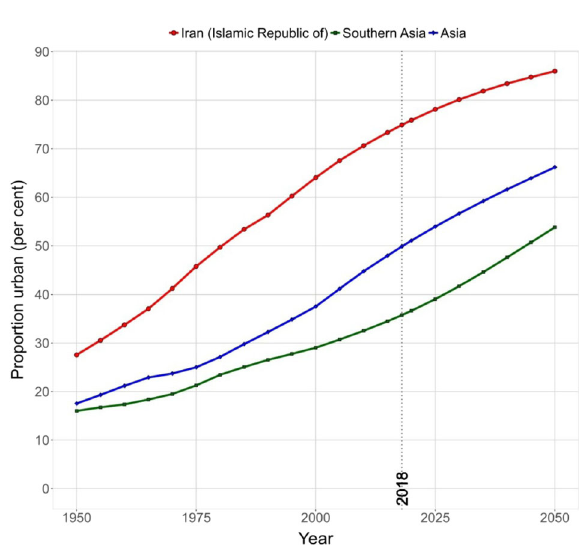
Fig. 2 Process of urbanization in southern Asia, Asia and Iran in 1950 – 2050. Urban population growth in south Asia and Iran ’ s shown in fi gure. The prospect of urban population growth in Iran indicates that this trend will increase up to 85% by 2050. This is a considerable growth, which exhibits a prevailing gap with other Asian or south Asian countries. The share of urban population in these areas compared to their subregions. Figures are expressed as a percentage of the total population, 1950 –